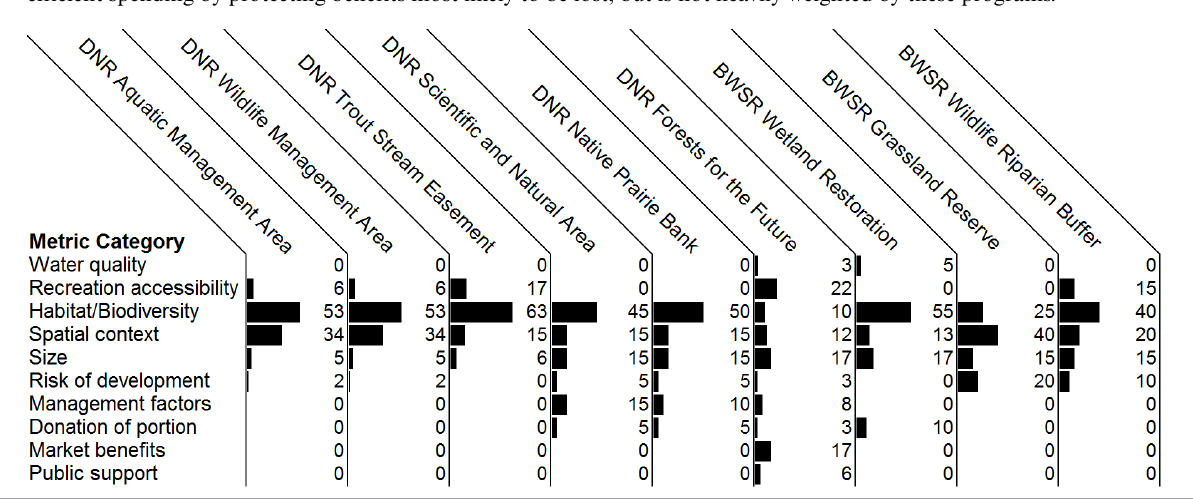
Fig. 1 . Conservation programs and the weight (%) they place on different metric categories when scoring potential acquisitions. Despite many programs and funds highlighting water quality and recreation as priorities, very little weight is placed on metrics related to water or the accessibility of acquisitions. The risk of development is also important for efficient spending by protecting benefits most likely to be lost, but is not heavily weighted by these